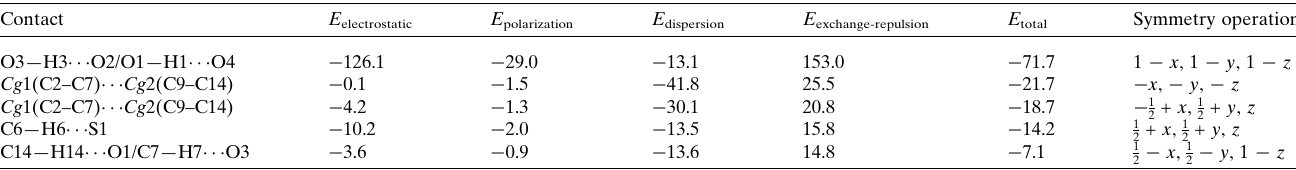
Table 2 Interaction energies (kJ mol (cid:3) 1 ) for selected close contacts. Contact